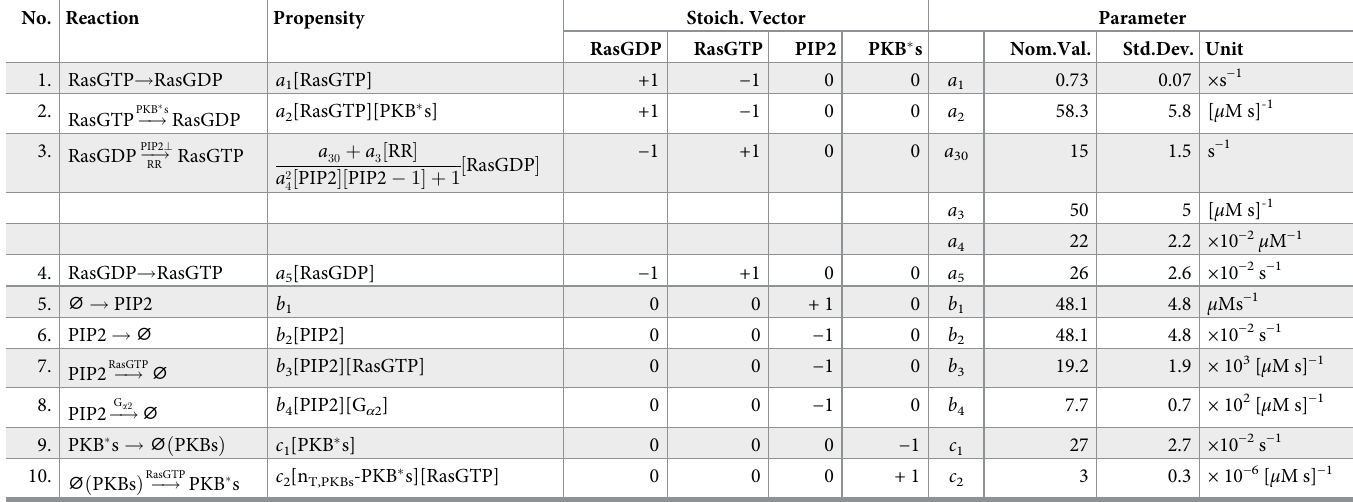
Table 4. Parameters for signal transduction excitable module. The nominal values for the diffusion constants are: D RasGDP = D RasGTP = D PIP2 = 0.05, ¼ 0 : 4 m m 2 s (cid:0) 1 . The standard deviations in the diffusion constants were chosen to be 20% of the respective nominal values. The peak values are: RasGTP = 165,000 D PKB � s molec; PKB � s = 275,000 molec; PIP2 = 1,000 molec/ μ m 2 [58]. Further details are in S1 File. No. Reaction Propensity Stoich.